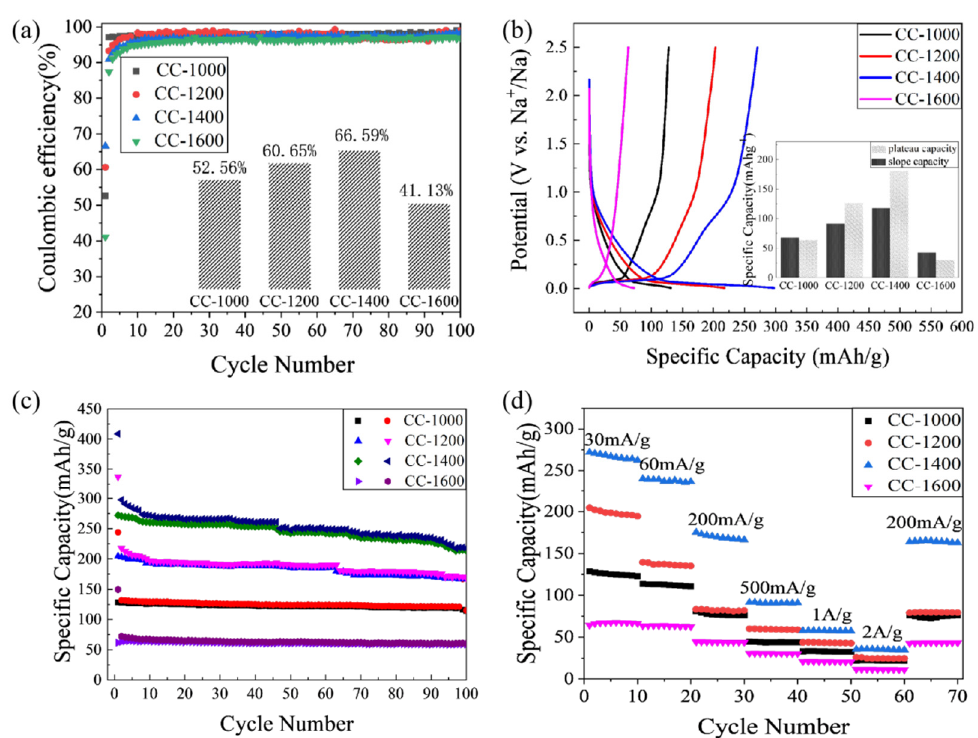
Figure 7. ( a ) The Coulombic efficiency of discharge/charge profiles (inset: the ICE of dis- charge/charge profiles); ( b ) the second galvanostatic discharge/charge profiles (inset: the plateau capacity and slope capacity of the second cycle) of CCs at a current rate of 30 mA/g; ( c ) cyclic performance; and ( d ) rate capability of CCs.